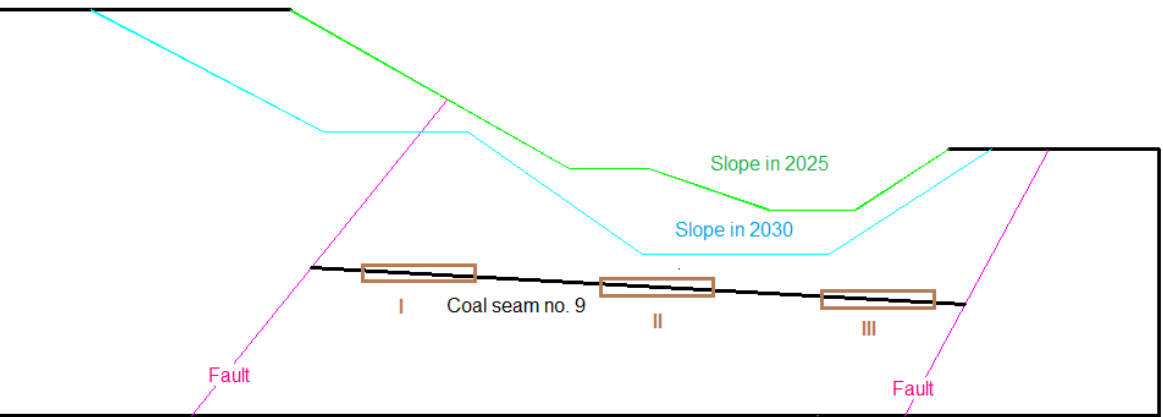
Figure 5: Calculation variants due to pit slope stages and monitoring points on the slope surface.